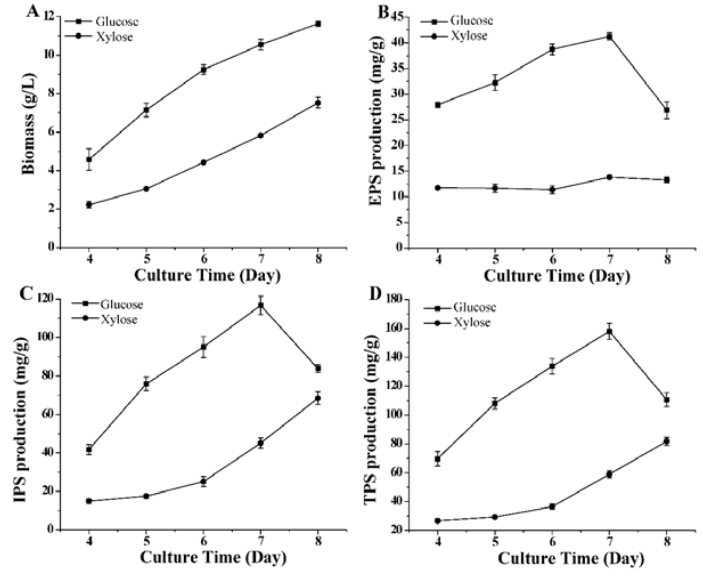
Figure 1. Effect of the carbon sources in culture medium on production of biomass ( A ), extracellular polysaccharides ( B ), intracellular polysaccharides ( C ), and total polysaccharides ( D ) by Ganoderma lucidum .